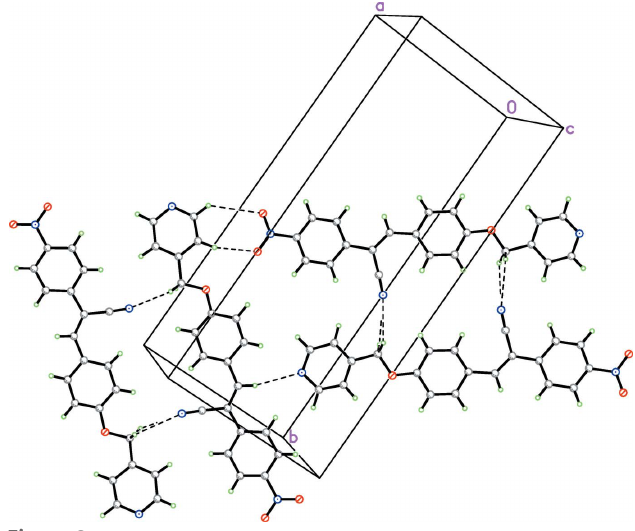
Figure 2 C—H (cid:2)(cid:2)(cid:2) N and C—H (cid:2)(cid:2)(cid:2) O hydrogen bonds connect the molecules into layers parallel to (102).